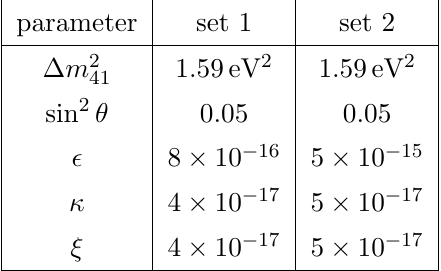
and (cid:1) m 2 , 21 31 and (cid:1) m 2 . 21 31